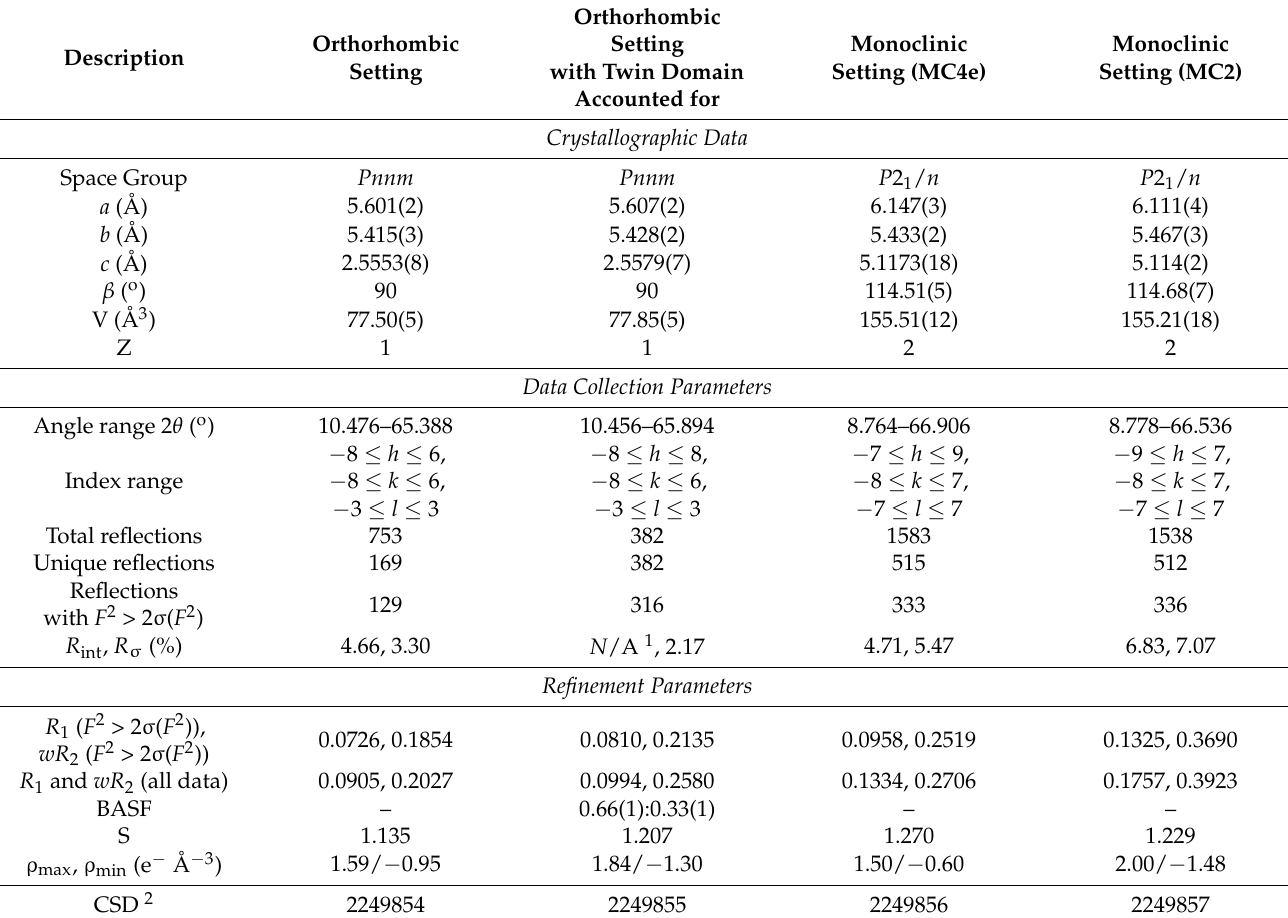
Table 1. Crystallographic data, data collection and refinement parameters of SM